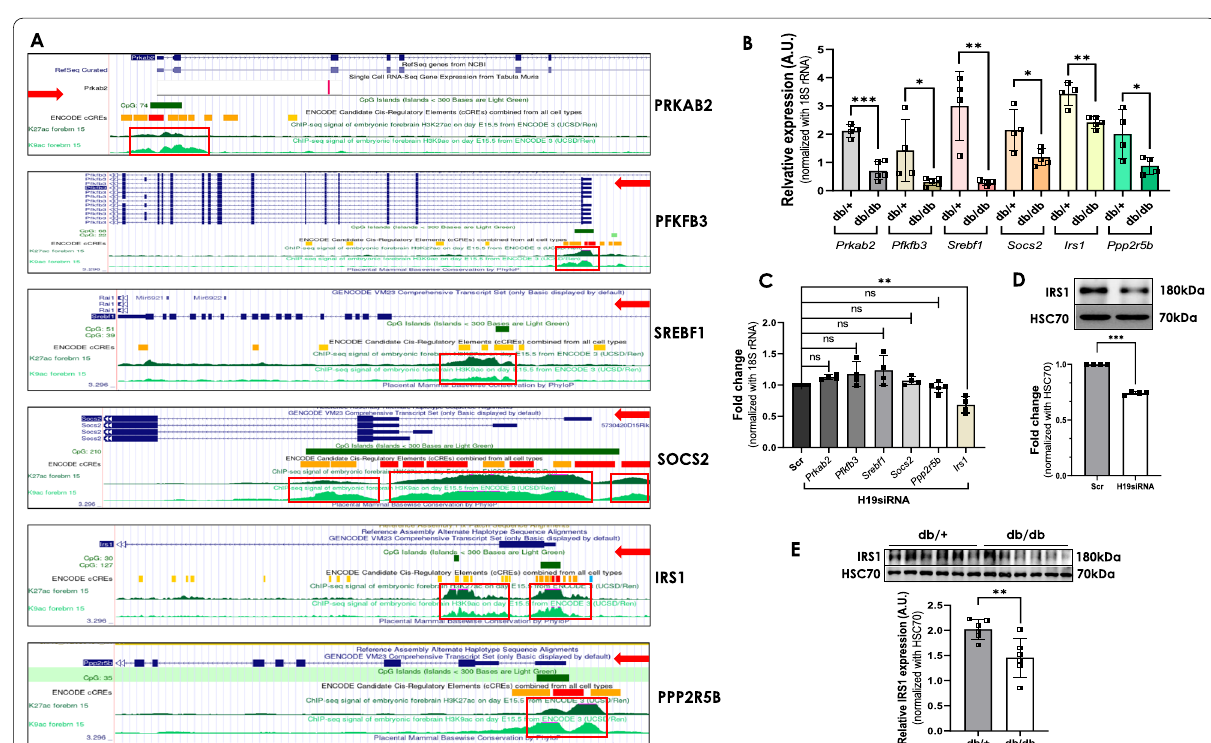
Fig. 4 LncRNA H19 inhibition decreases IRS1 levels in C2C12 cells. A Putative acetylation marks as identified on the regulatory promoter regions of PRKAB2, PFKFB3, SREBF1, SOCS2, IRS1 and PPP2R5B using the UCSC genome database. Regions enclosed within the red box upstream to each gene represent the site with potential histone acetylation (K9 and K27) marks, red arrows represent the orientation of the gene. B Total RNA was isolated from skeletal muscle tissues of normal db/ and diabetic db/db mice (n 4) and 1 µg RNA was reverse transcribed and transcript levels of Prkab2, + = Pfkfb3, Srebf1, Socs2, Irs1 and Ppp2r5b were evaluated by qRT-PCR. 18S rRNA was taken as the normalization control. C C2C12 cells were differentiated and transfected with either the scramble or H19 siRNA (5 nM) and after 48 h, total RNA was isolated, reverse transcribed and the transcript levels of Prkab2 , Pfkfb3 , Srebf1 , Socs2 , Irs1 and Ppp2r5b were assessed using gene specific primers. 18S rRNA was taken as the endogenous control. Experiments were done in at least four independent sets. D Cells transfected as in “C” were lysed and 20–30 µg protein was run on SDS-PAGE and subjected to Western Blot analysis using anti-IRS1 antibody. HSC70 was taken as the loading control. Experiments were done in four independent sets. E Skeletal muscle tissue lysates (30 µg) of normal db/ and diabetic db/db mice (n 6) were subjected to Western Blot analysis using anti-IRS1 + = antibody. HSC70 was taken as the loading control. Given below is the densitometric analysis of the normalized values of six mice in each group. Values presented are means SD of four independent experiments. *p 0.05; **p 0.01; ***p 0.001¸ns: ± ≤ ≤ ≤